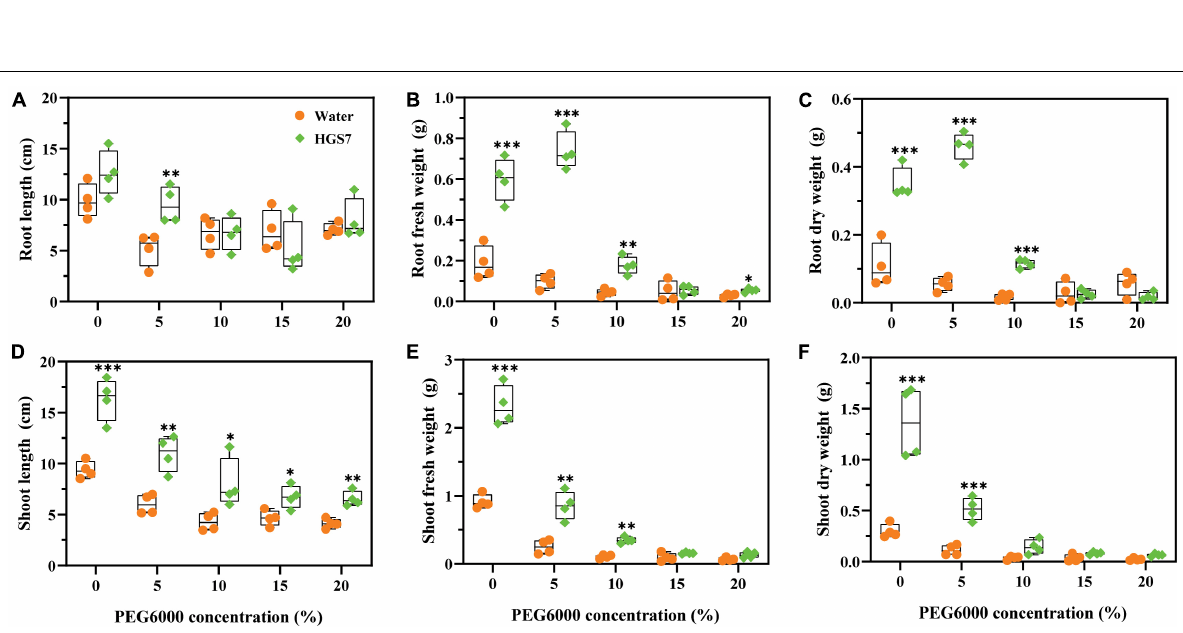
Frontiers in Plant Science |